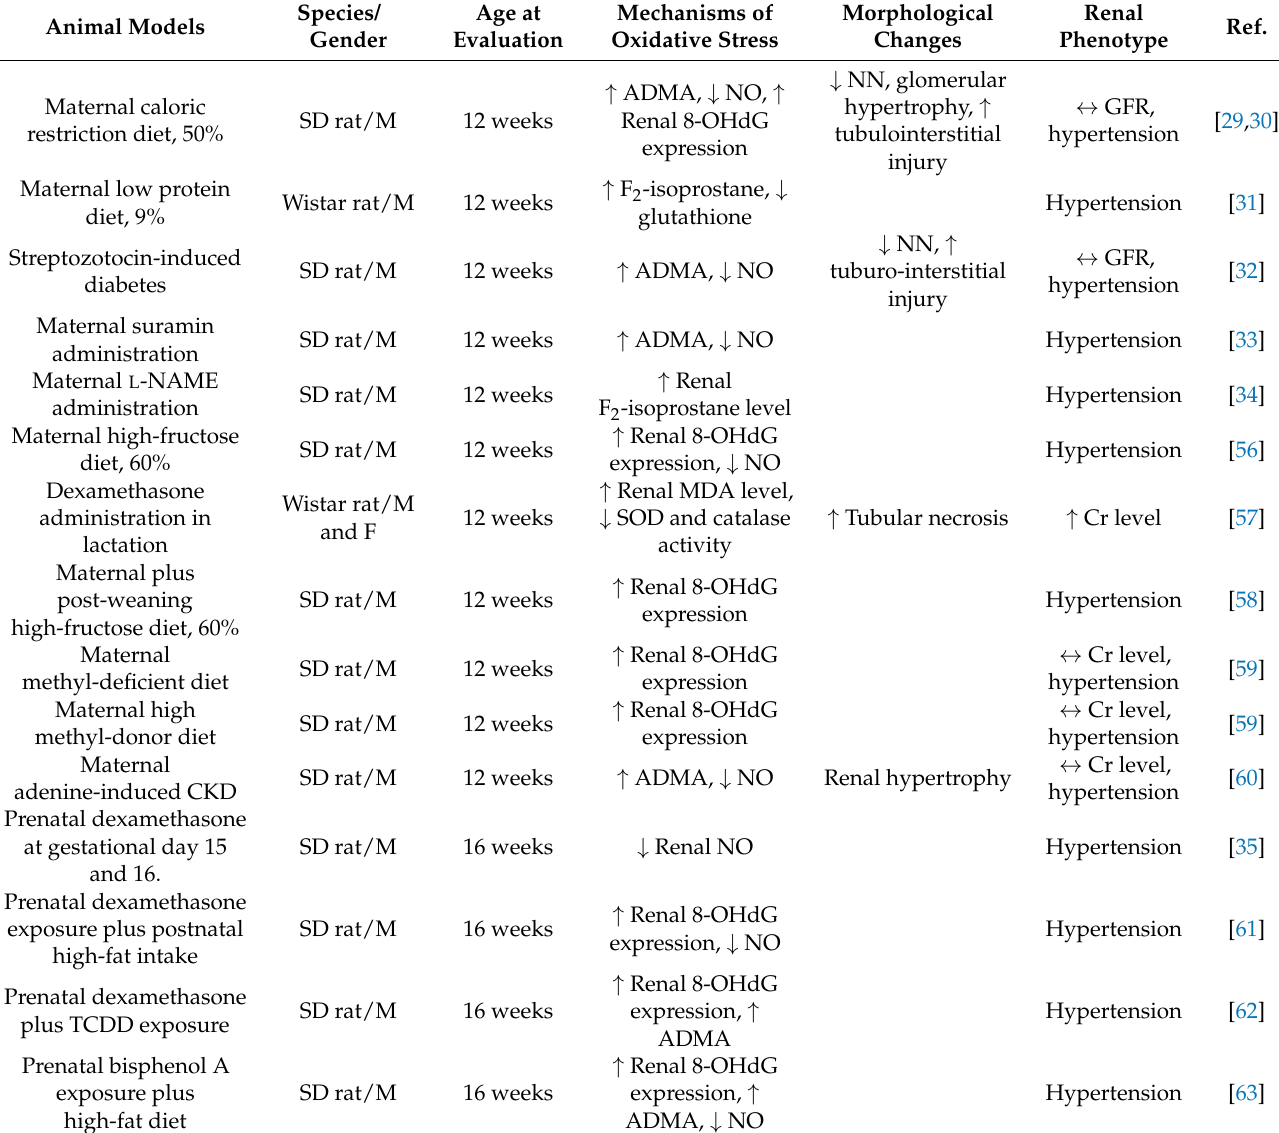
Table 1. Summary of oxidative stress-related renal programming following maternal insults in animal models. Species/ Age at Mechanisms of Animal Models Gender Evaluation Oxidative